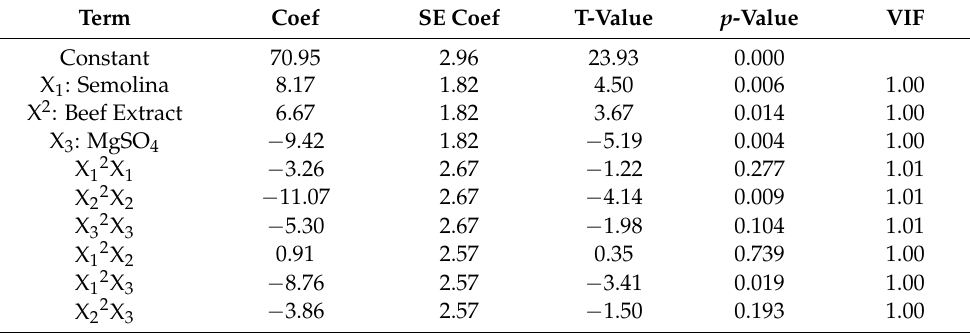
Table 3. Coded coefficients for antifungal activity against C. archidechola